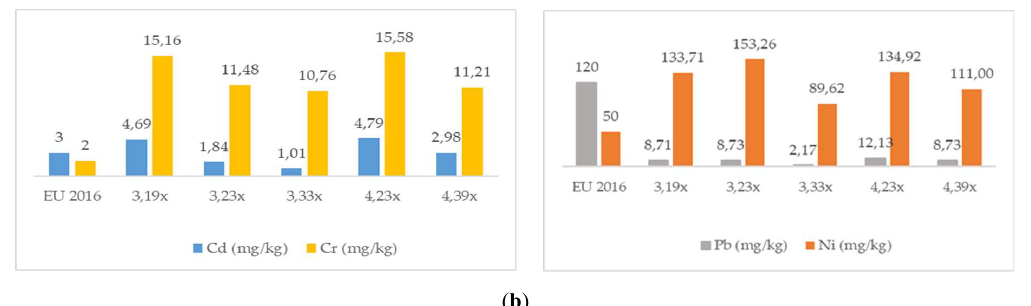
Figure 2. Concentration of heavy metals in the concentrated leachates. ( a ) from October 2017; ( b ) from June 2018.